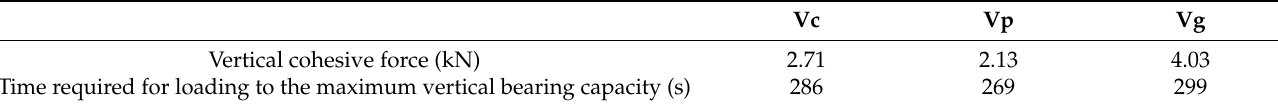
bearing capacity.